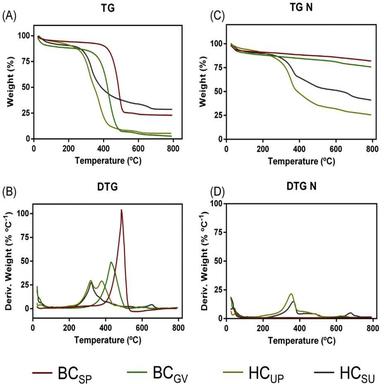
A) Thermogravimetric (TG) and B) corresponding derivative thermogram (DTG) profiles of samples in air atmosphere. C) Thermogravimetric (TG) and D) corresponding derivative thermogram (DTG) profiles of samples in nitrogen atmosphere.